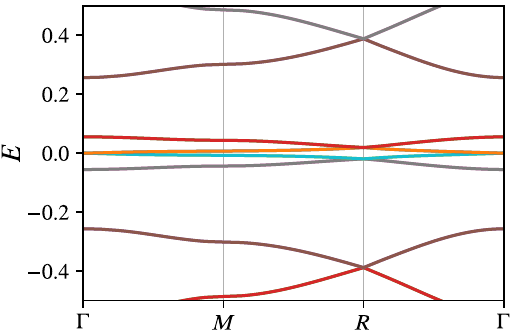
FIG. 13. The band structure of the C4FB model near the parameter values at which the velocity vanishes. Each band in the picture is doubly degenerate as a result of an antiunitary symmetry C 2 T 0 that squares to − 1 . We therefore find that there are eight bands connected to E ¼ 0 , all of which become exactly flat when the velocity